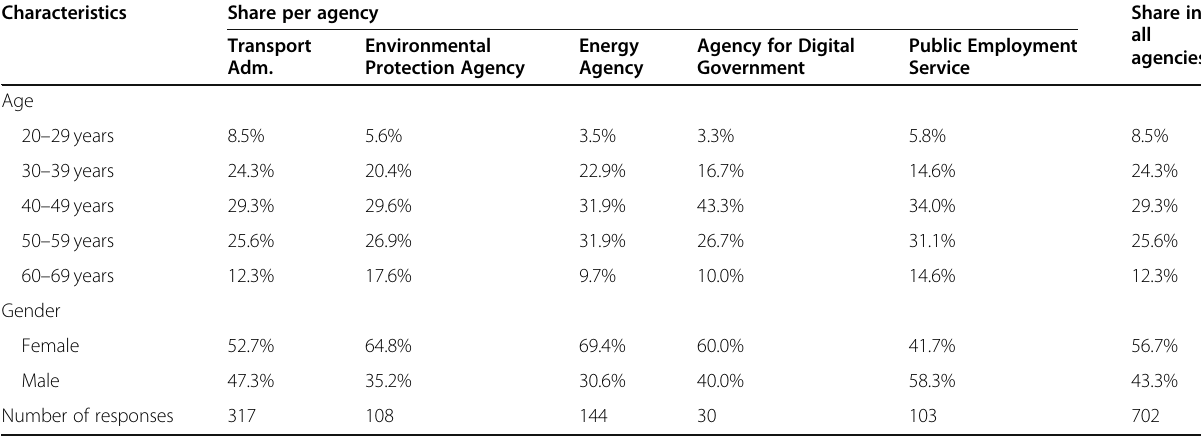
Table 2 Background Statistics of Respondents Per Agency and Total